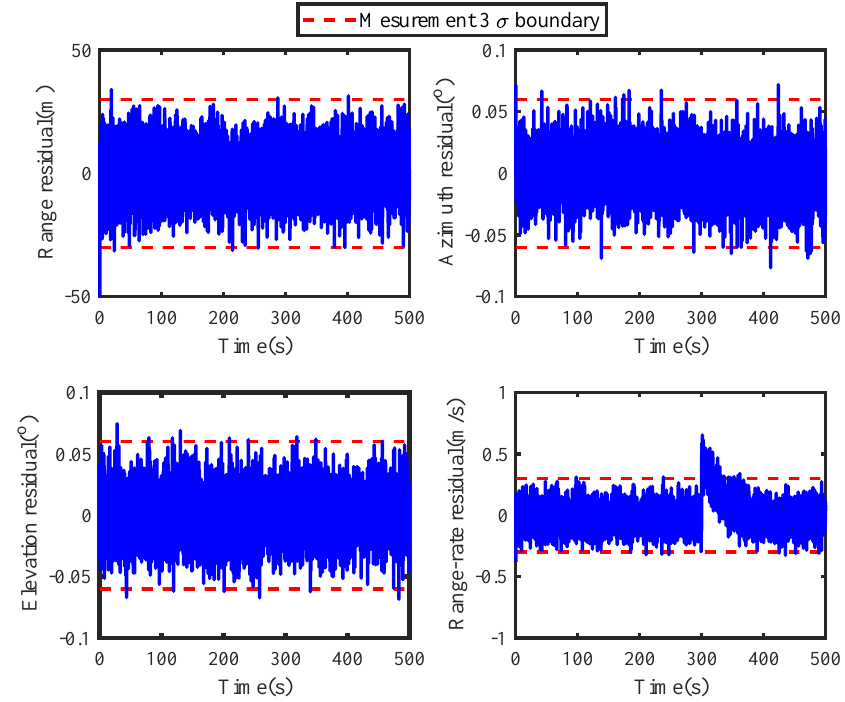
Figure 7. Measurement Residuals of the